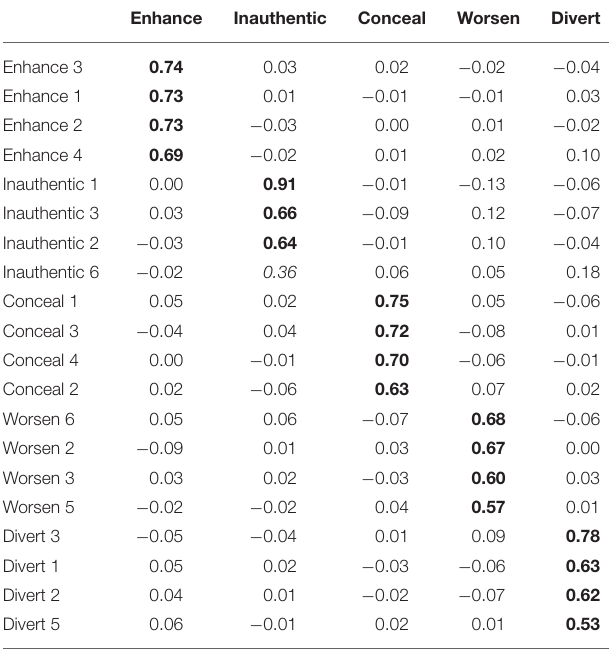
TABLE 1 | Sample details for Study 1.